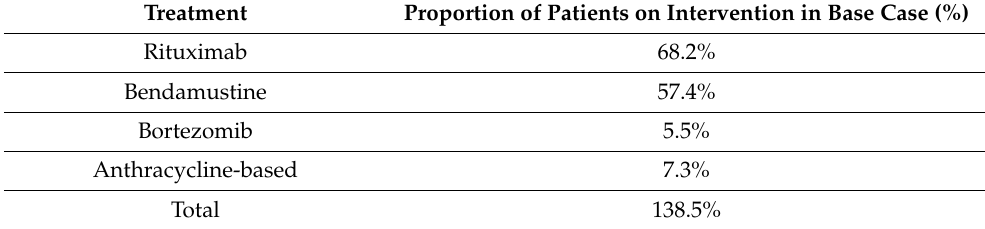
Table 2. Proportion of patients on each of BSC treatments.